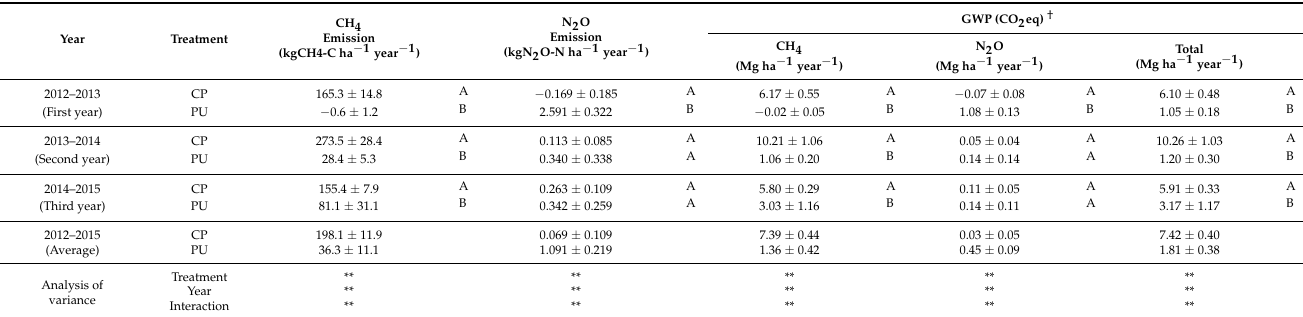
Table 3. Annual CH 4 , N 2 O and their CO 2 eq emissions during the survey period (2012–2015). Year